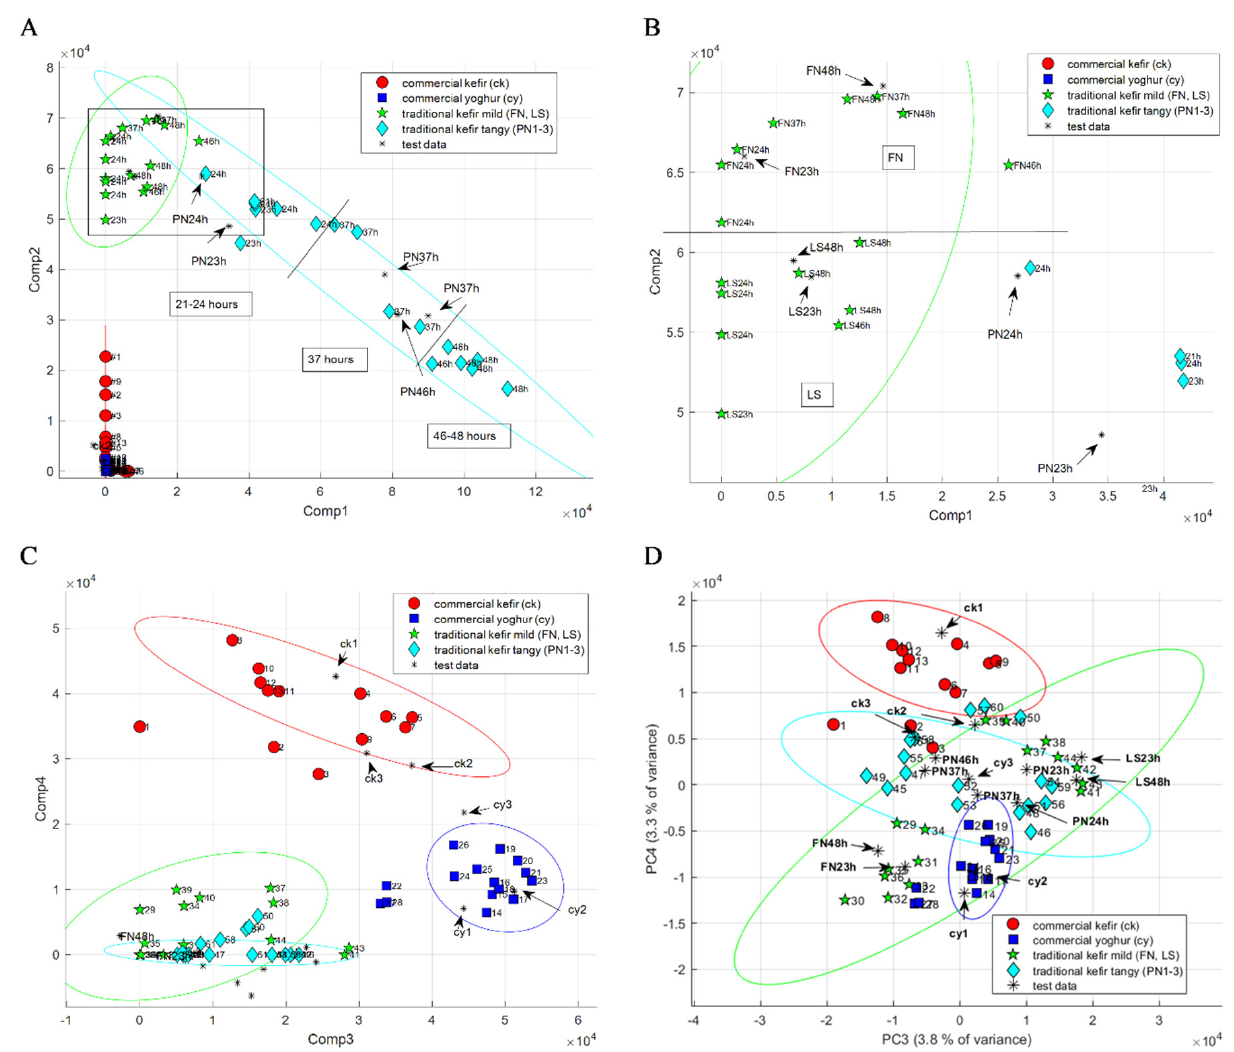
Figure 3. Scatter plot based on non-negative matrix factorization (NNMF) and principal component analysis (PCA) of preprocessed HS-GC-HTIMS spectra of fermented dairy, showing ( A ) NNMF-C1 and NNMF-C2, ( B ) NNMF-C1 and NNMF-C2 (enlarged), ( C ) NNMF-C3 and NNMF-C4, and ( D ) PC3 and PC4.